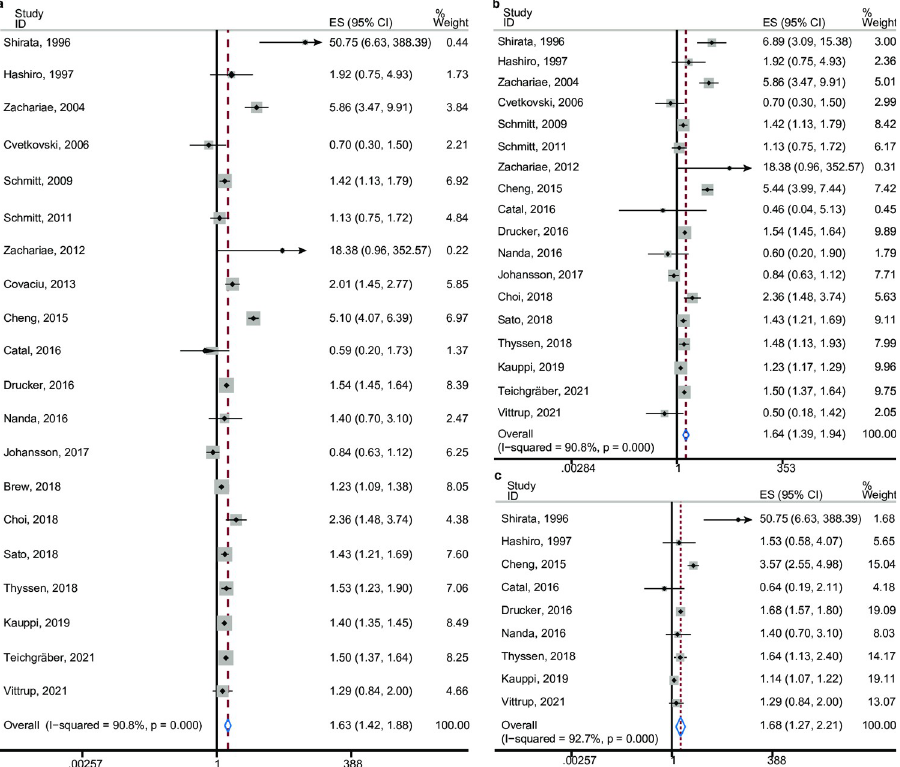
Fig 2. Forest plots of the three groups. Forest plot of eczema associated with ( a ) anxiety/depression, ( b ) depression, and ( c ) anxiety groups. The pooled effect size and 95% confidence interval are indicated with a white diamond. The effect size and 95% confidence interval for each study are indicated by a black diamond and black line. The gray squares refer to the weight of each study calculated in the pooled effect size.